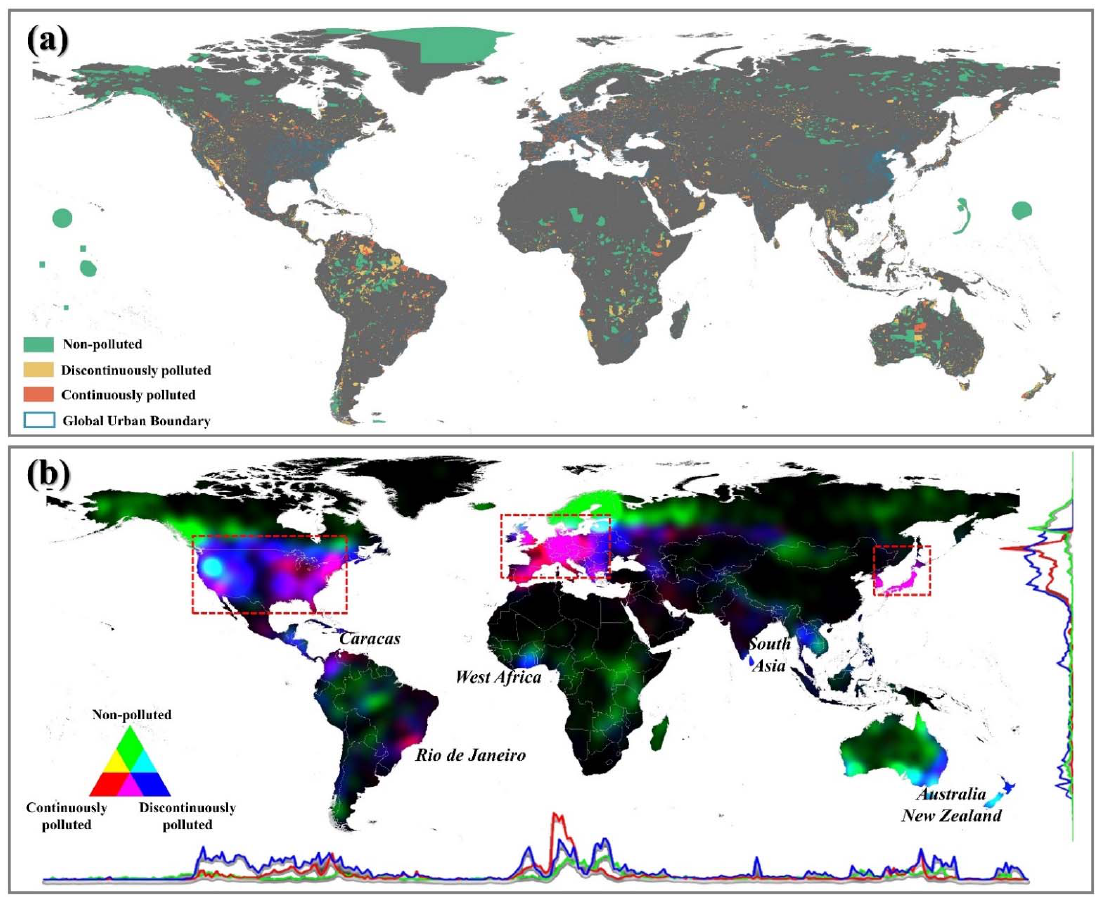
Figure 4. Spatial distribution of different light pollution categories ( a ) and their composited visualization using continuously polluted (R), non-polluted (G), and discontinuously polluted (B) ( b